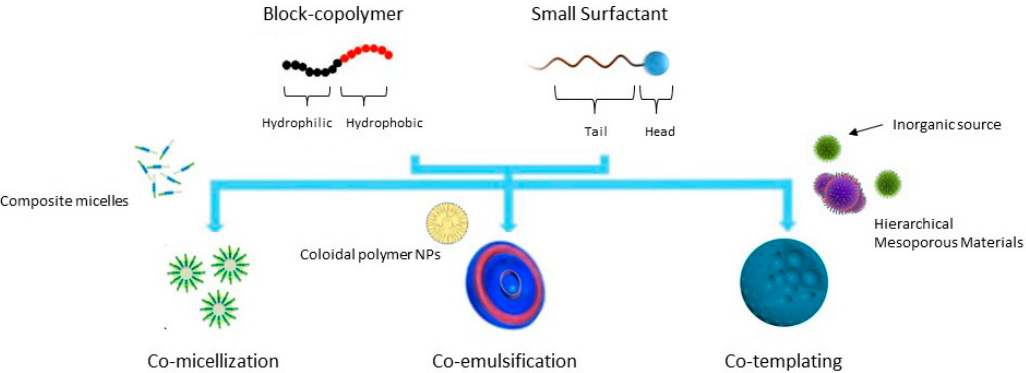
Figure 3. Binary amphiphilic co-assembly of amphiphilic block-copolymers with small weight sur- factants.